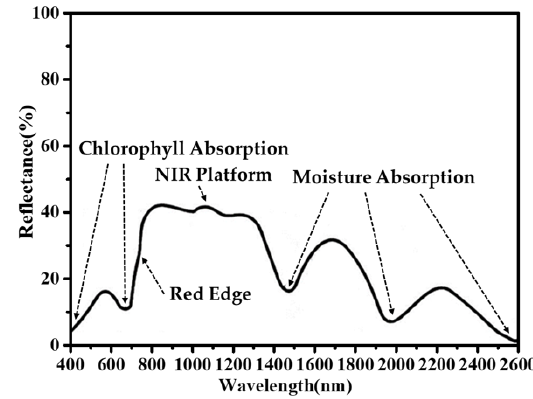
Figure 1. Approximate reflectance spectrum of green plants.